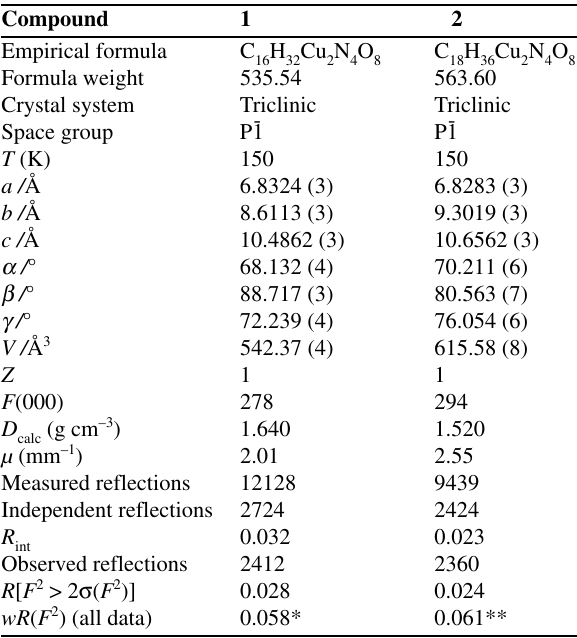
Table 1 . Crystallographic data and structural refinement for com- plexes 1 - 2